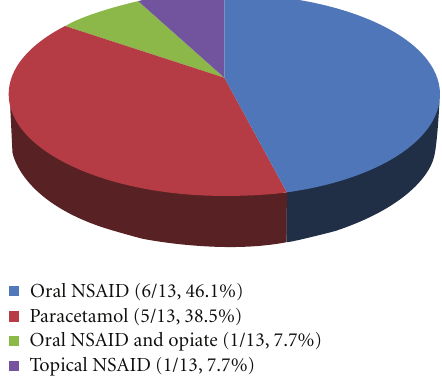
Figure 1: Hand OA participant analgesic use. The subgroups with respect to analgesic use in the hand OA group were classified as (1) oral NSAID including diclofenac, ibuprofen, or celecoxib; (2) paracetamol up to 1g four times daily; (3) oral NSAID (diclofenac) plus opiate (cocodamol); (4) topical NSAID (ibuleve gel). Proportions of participants in each group are shown in addition to